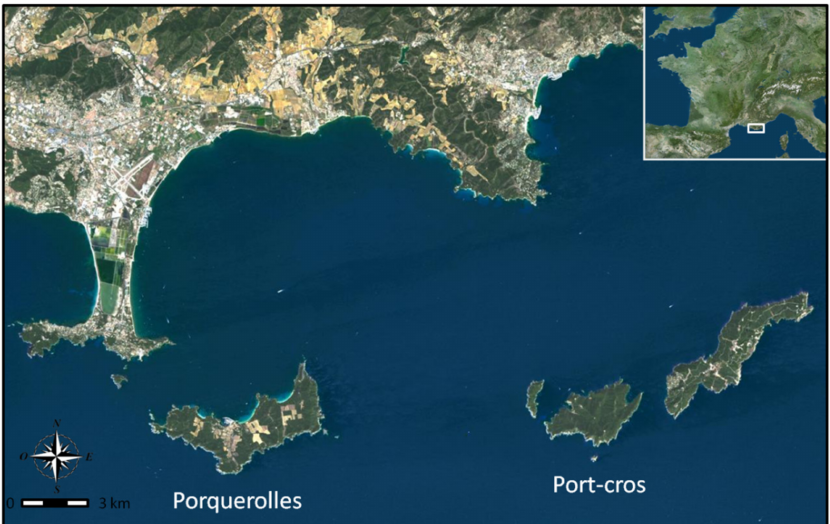
Figure 1. Study location Port-Cros and Porquerolles are situated off the south-east coast of France’